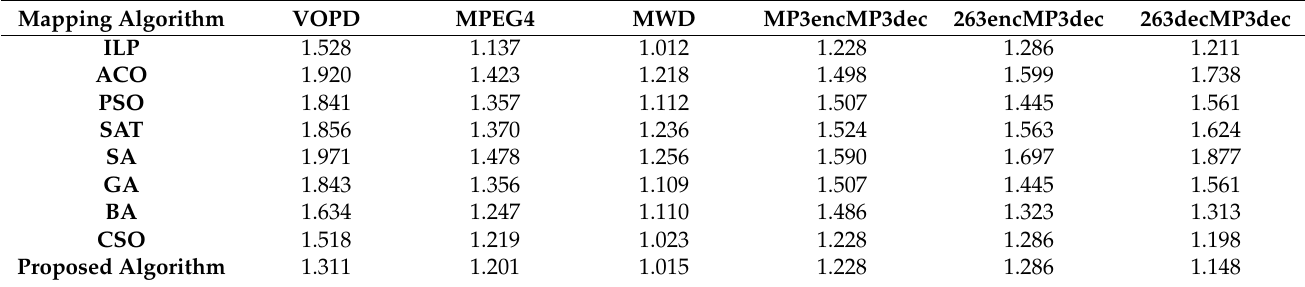
Table 3. Total Power (W) for 2D NoC 4 × 4 Mesh for standard NoC benchmarks.